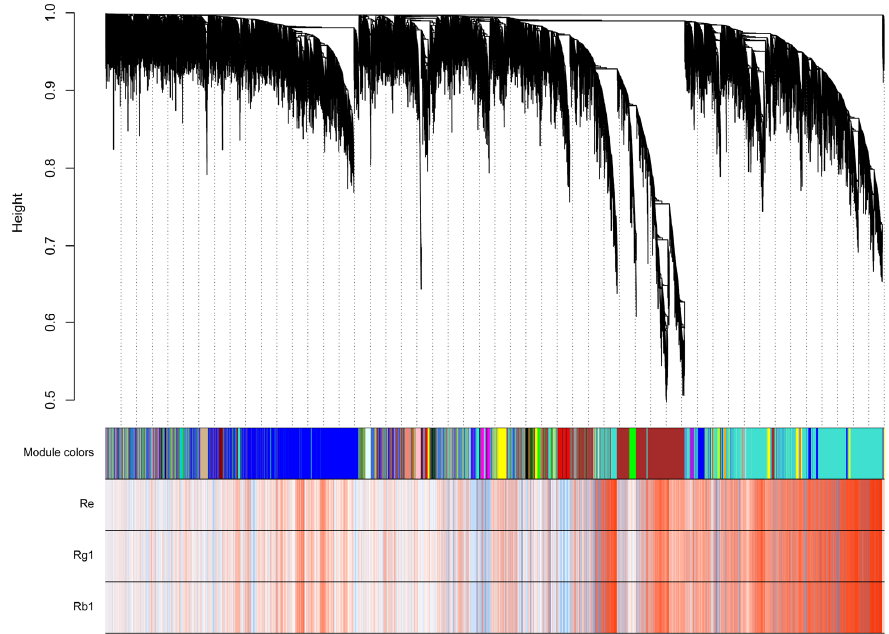
Figure 3. Co-expression analysis with 39,493 genes through the WGCNA. The modules corresponding to the branches are represented by colors in the first color band underneath the tree, and the remaining color bands reveal the correlation between transcripts and ginsenoside-Rg1, ginsenoside-Re and ginsenoside-Rb1. The red module indicates a highly positive correlation with the corresponding gene, the white module denotes a weak correlation, and the blue module represents a highly negative correlation.